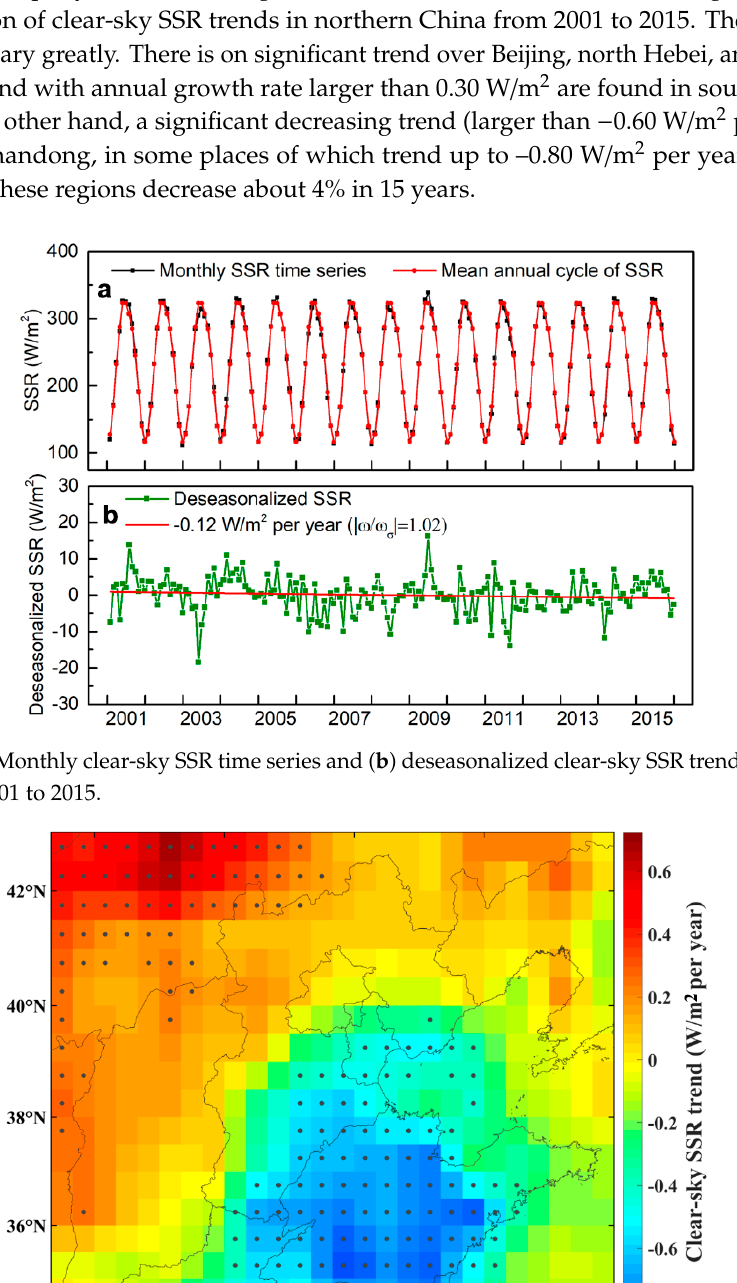
Figure 10. Monthly variations of aerosol optical depth (AOD) and water vapor in northern China during 2001–2015.